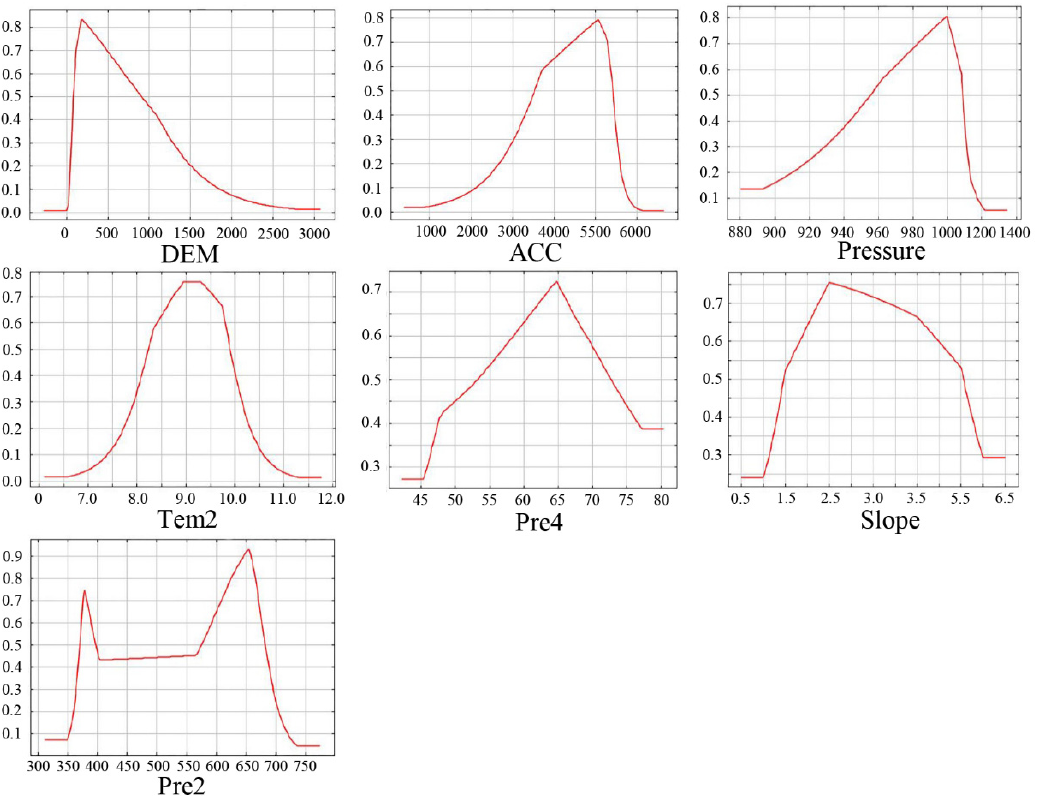
Figure A2. Feedback curves of dominant geographic environment variables for Masson Pine. DEM represents digital elevation model; Acc represents accumulated temperature; Pressure represents air pressure; Tem2 represents annual average diurnal temperature difference; Pre4 represents precipitation deviation; Pre2 represents rainfall in the wettest season.